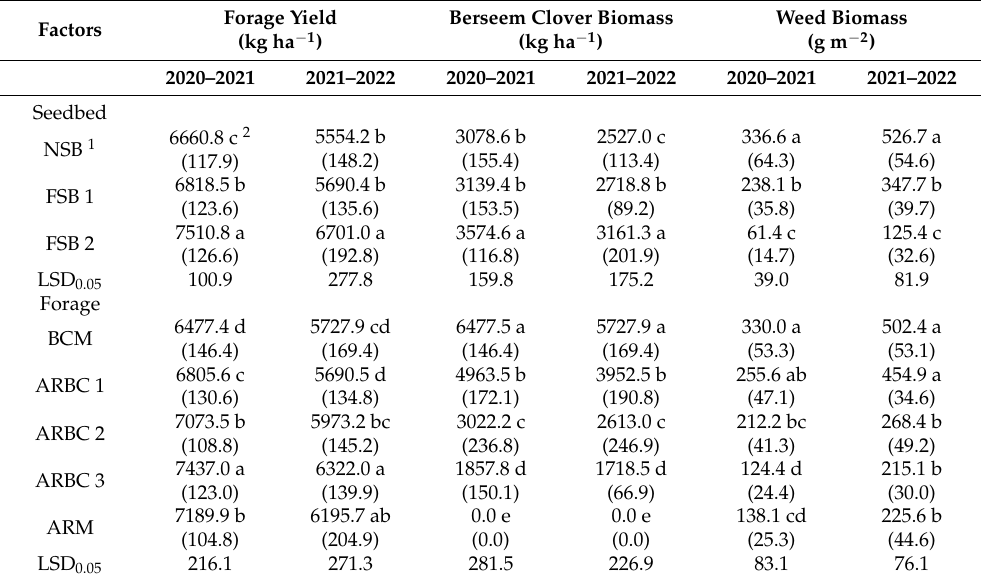
Table 5. Forage yield (kg ha − 1 ), biomass of berseem clover (kg ha − 1 ), and total weed biomass (g m − 2 ) in the first harvest of 2020–2021 and 2021–2022. Forage Yield Berseem Clover Biomass Factors (kg ha − 1 ) (kg ha − 1 )